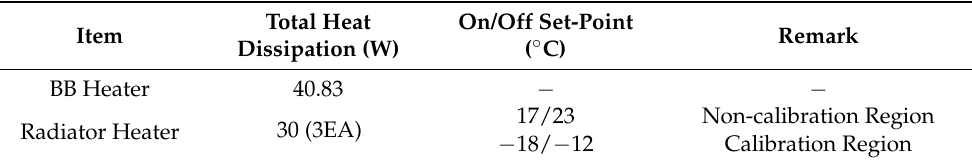
Figure 4. Thermal mathematical model of BB system for in-orbit analysis. ( a ) Detailed view; ( b ) Overall view. Table 2. Heat dissipation and on/off set-point of heaters.